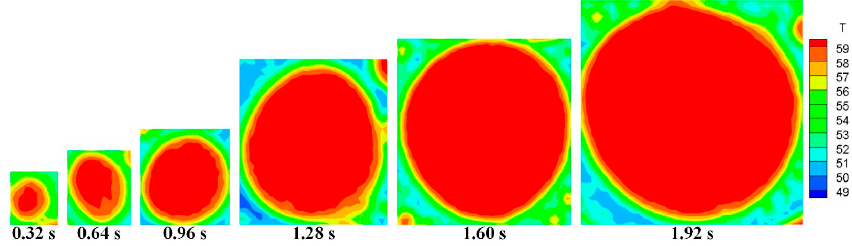
Figure 6. Top view of the temperature distribution of the typical single droplet surface at different times.